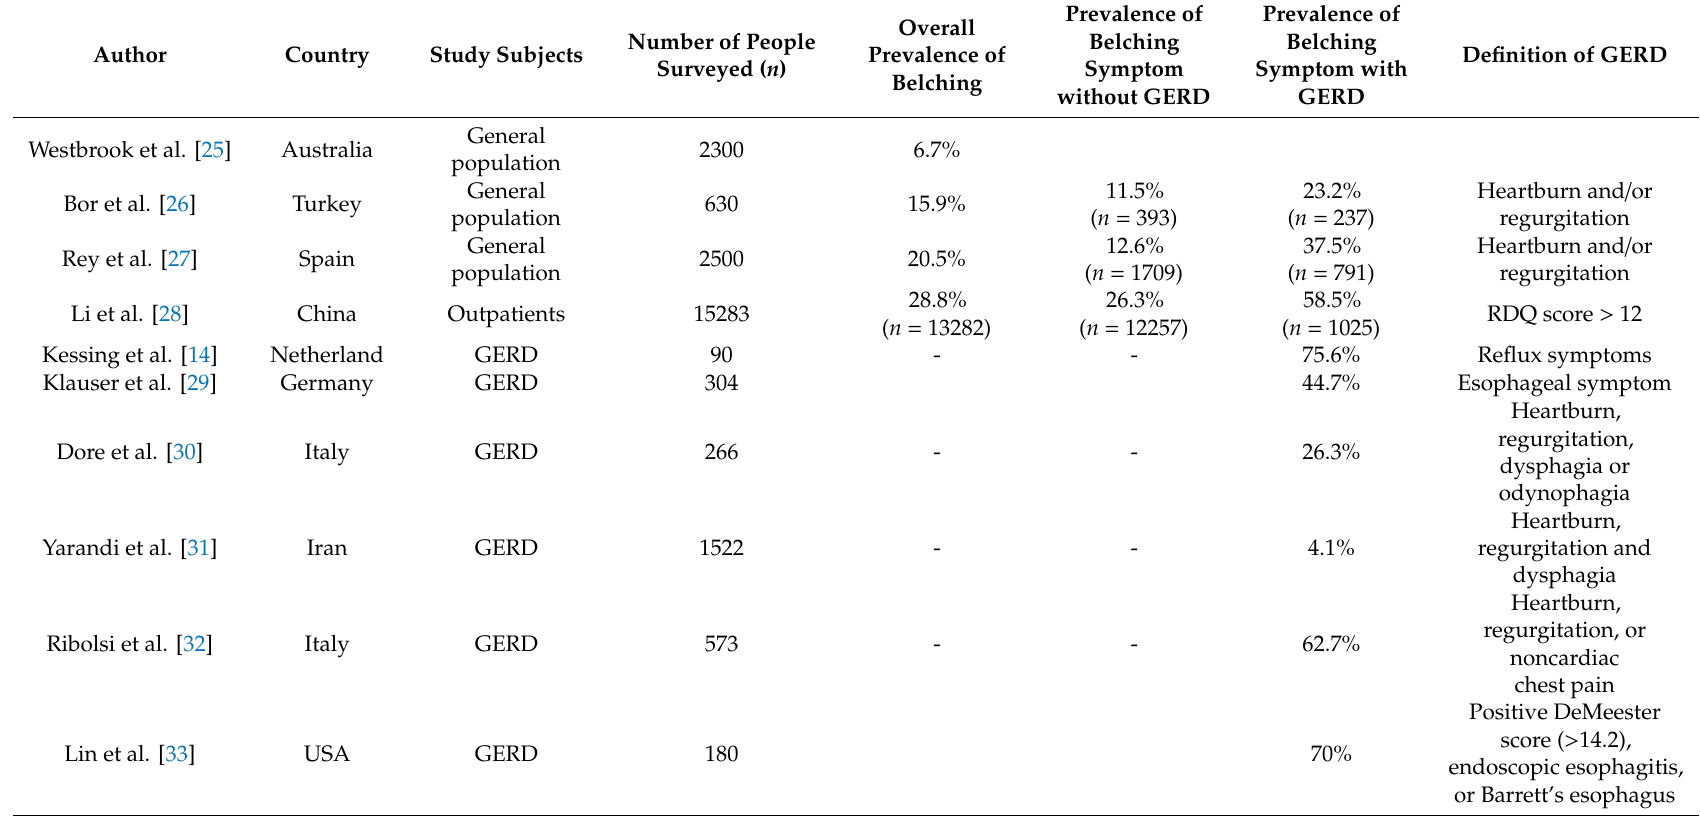
Table 1. Prevalence of belching